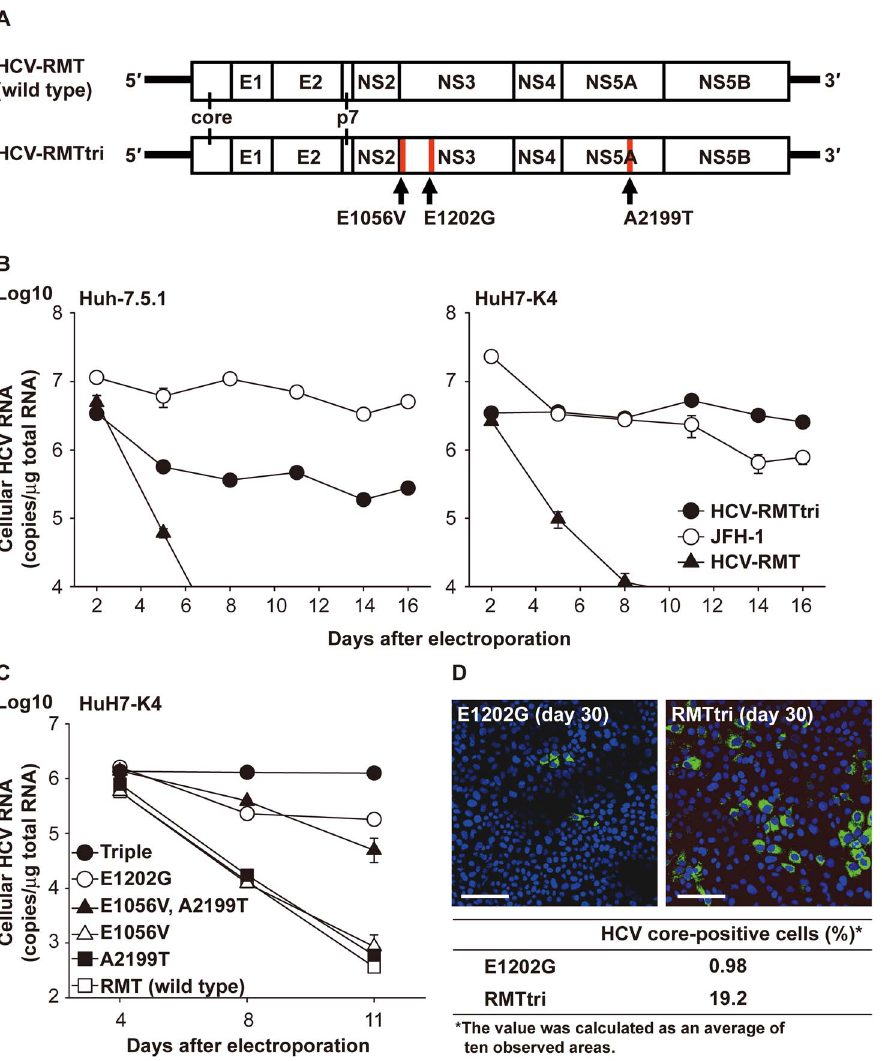
Figure 2. Invitro replication ability of HCV-RMT derivative genomes. (A) Schematic representation of construction of the HCV genome and the sites of adaptive mutations (red bars). (B) Electroporation of the generated HCV-RNA genomes of wild-type HCV-RMT (closed triangles), HCV-RMT with triple mutations (HCV-RMTtri; closed circles), and the JFH-1 strain (open circles) into Huh-7.5.1 or HuH7-K4 cells. The experiments were carried out in duplicate. (C) Comparison of the in vitro replication ability of each HCV-RMT derivative in HuH7-K4 cells. The experiments were carried out in duplicate. Wild type: open squares, E1202G: open circles, E1056V: open triangles, A2199T: closed squares, E1056V and A2199T: closed triangles, triple mutations: closed circles. (D) Immunostaining for the HCV core protein in HCV-RNA-electroporated cells. Scale bar = 100 m m. The percent of HCV core protein-positive cells (%) was calculated as an average of ten observed areas.